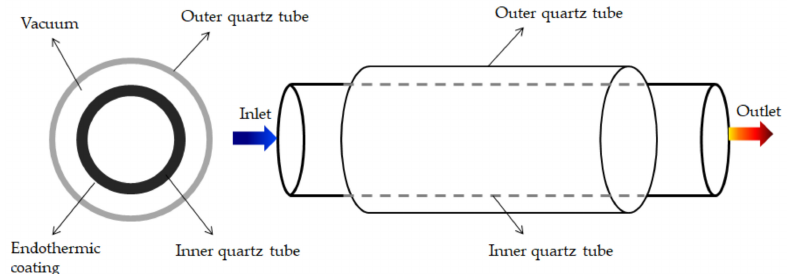
Figure 6. Cross-sectional view of a solar vacuum tube and a fluid-flow scheme through the tube.